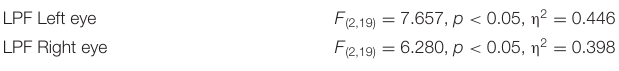
TABLE 5 | Repeated measure one-way ANOVA for each metric with effect size.